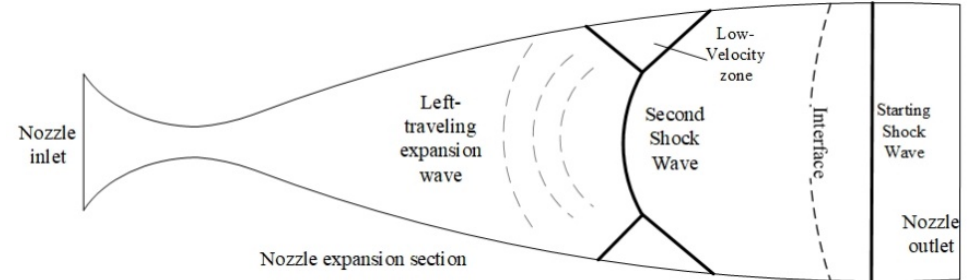
Figure 1. Nozzle starting waves.